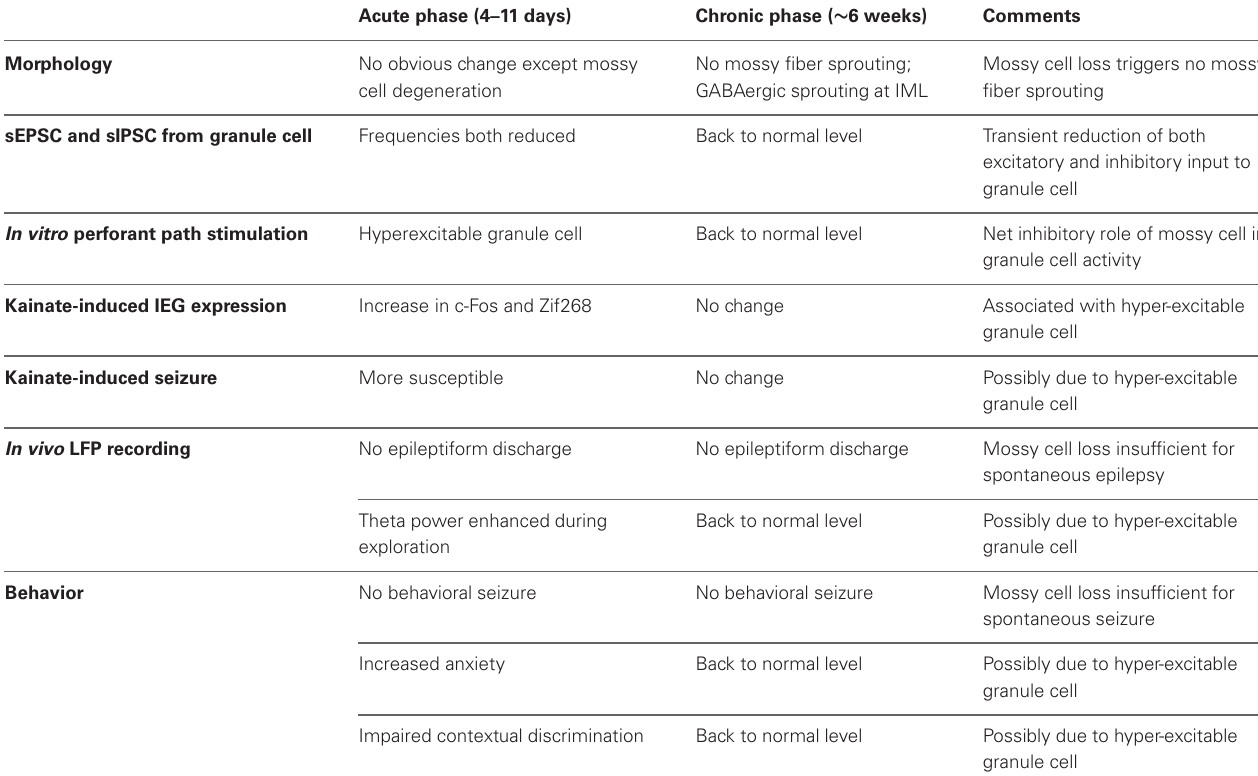
Table 1 | Summary findings after mossy cell-selective